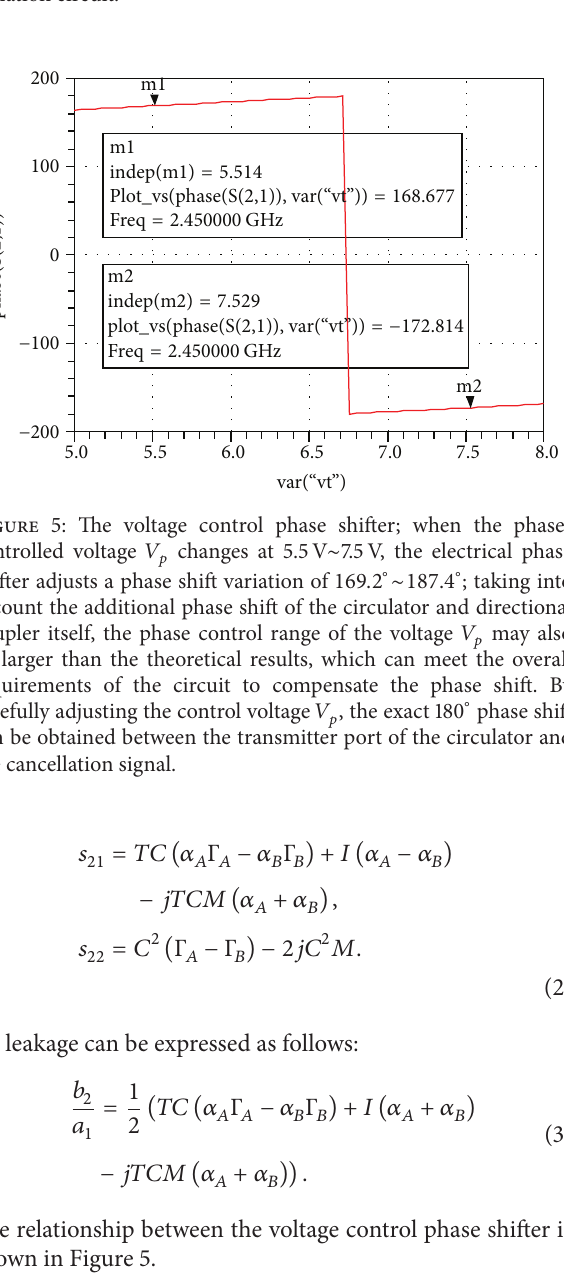
Figure 3: Carrier cancellation circuit.